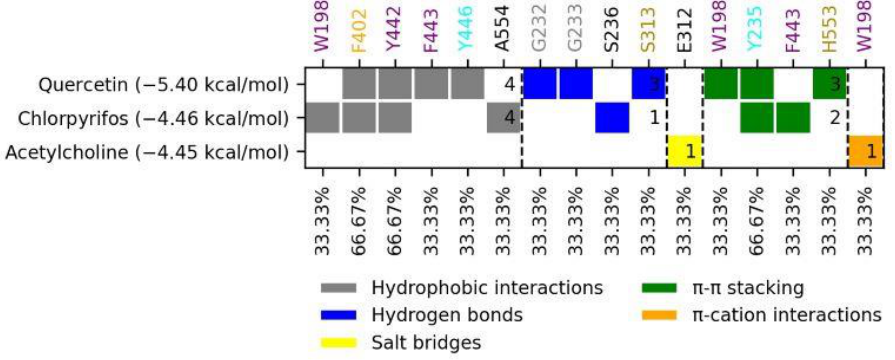
Figure 5. Fingerprints of quercetin interaction and control compounds on the active site of S. frugiperda AChE .